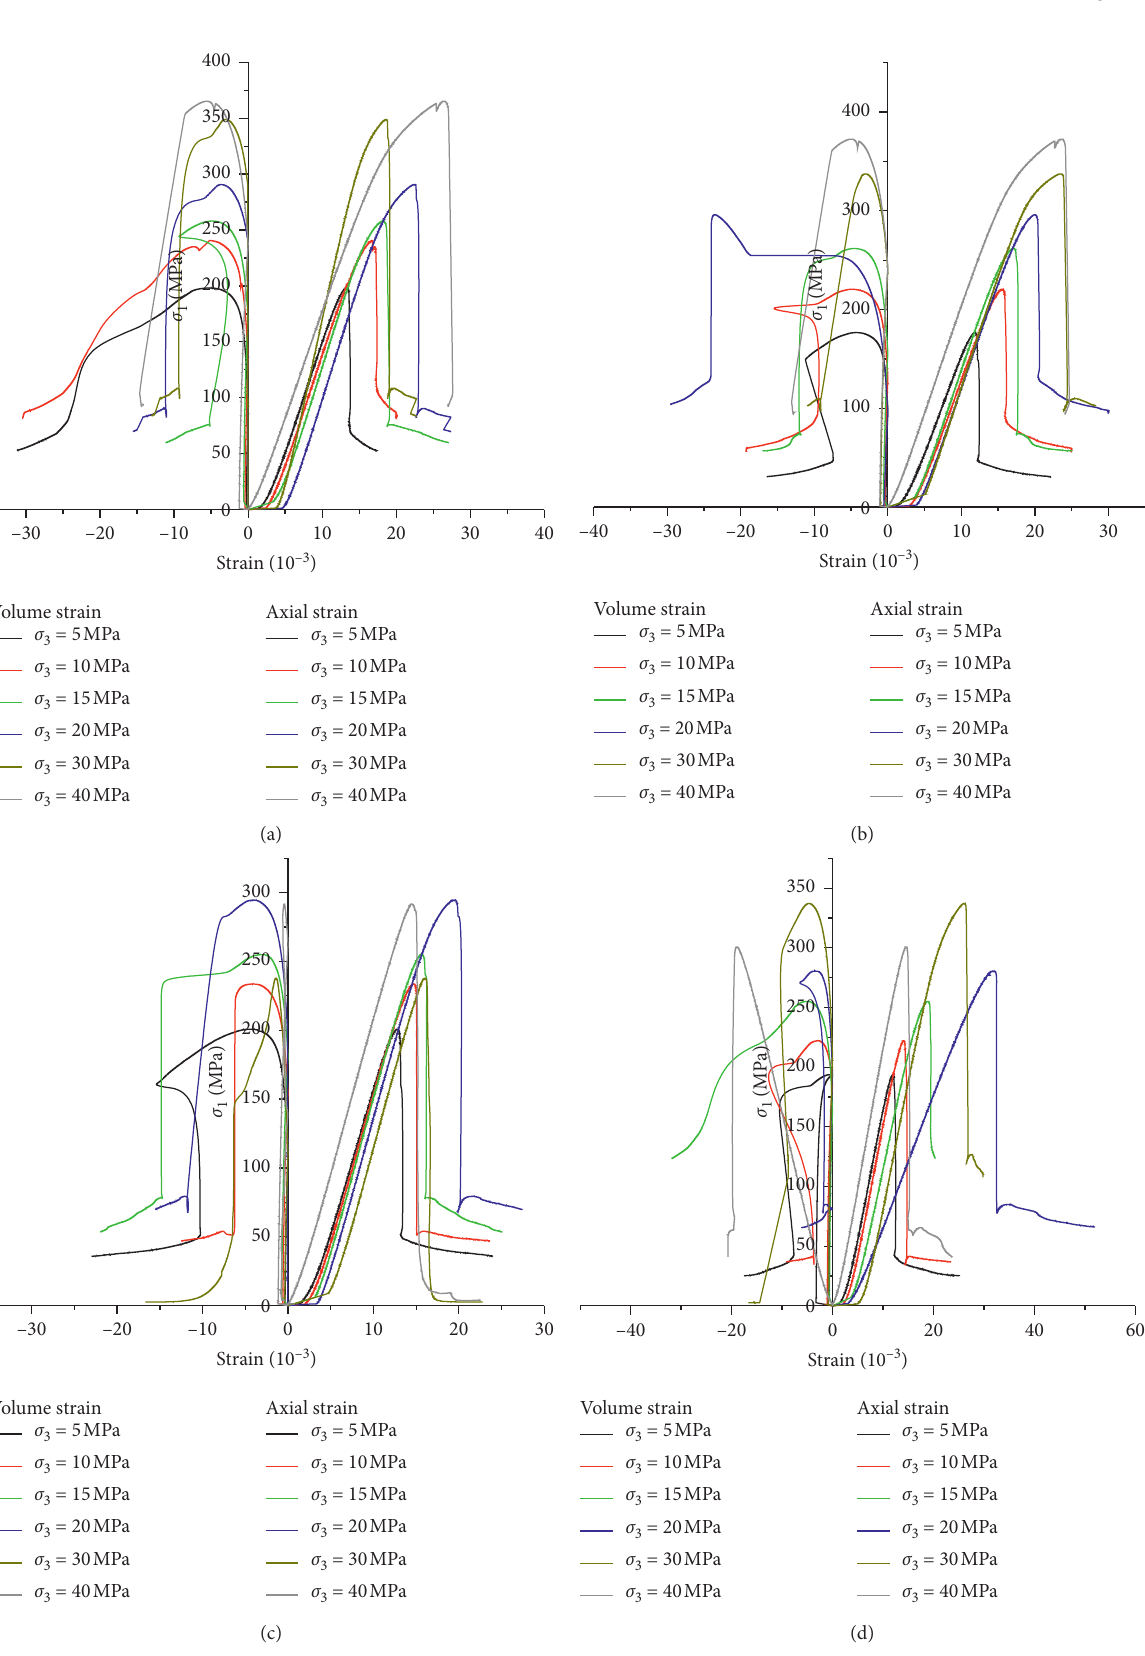
Figure 6: Triaxial compression stress-strain curves of the specimens under different confining pressures. (a) Pore size is 0mm. (b) Pore size is 10mm. (c) Pore size is 15mm. (d) Pore size is